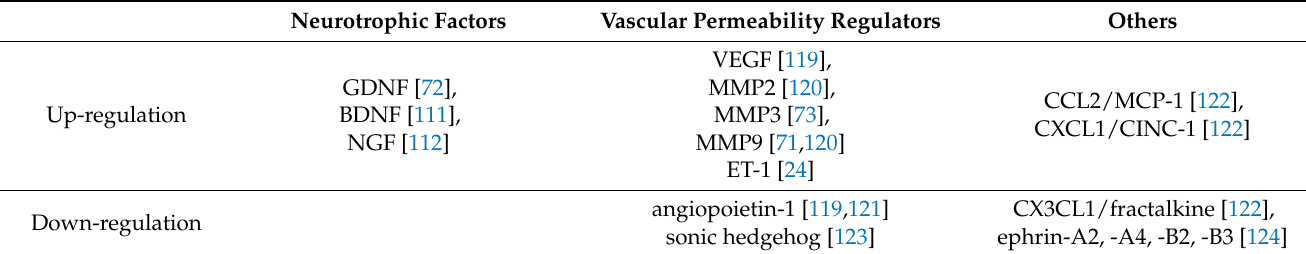
Table 2. Regulations of astrocytic bioactive factors by ET B